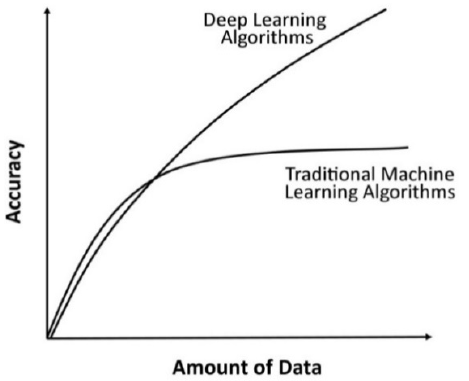
Figure 12. Comparison of classification accuracy of machine learning and deep learning models [64].